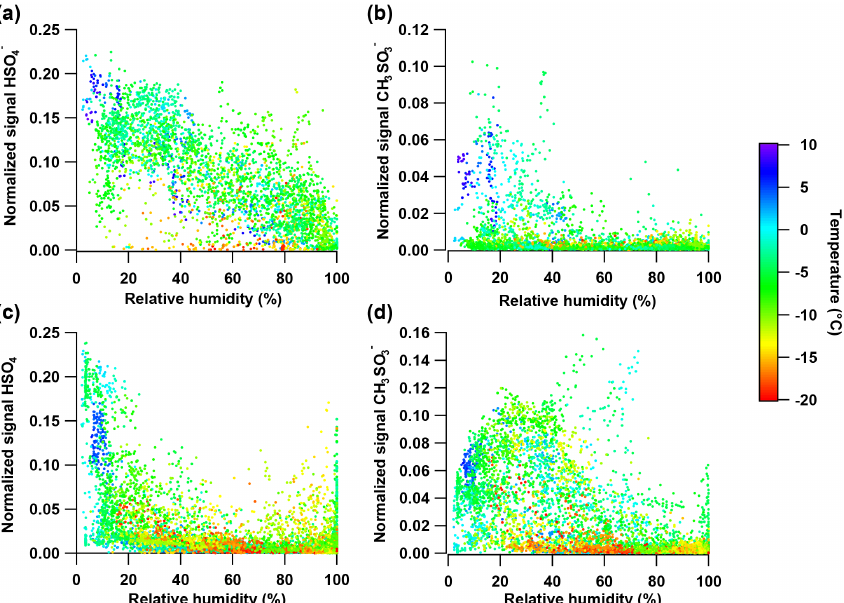
Figure 9. Dependence of HSO − and CH 3 SO − on relative humidity, as a function of temperature during the daytime (a, b) and night- 4 3 time (c, d) . The signal was normalized to the total ion